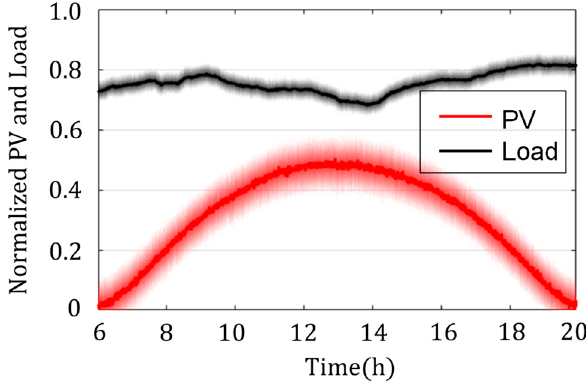
Figure 7. Normalized PV generation and load consumption profiles.